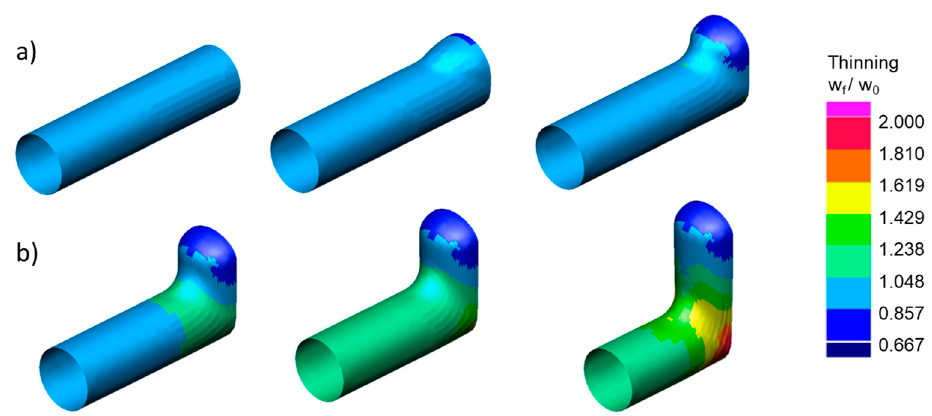
Figure 4. Small-Tee. Thinning at different instants of the hydroforming process. ( a ) initial deformation phase; ( b ) final deformation phase.